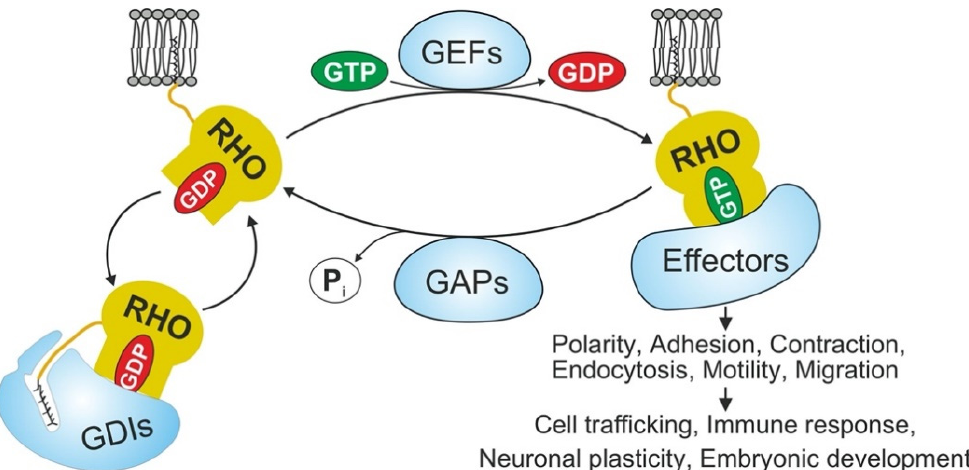
Figure 1. Molecular mechanisms of RHO GTPase regulation and signaling. Most of RHO GTPases (20 canonical members) act as molecular switches, in order to transduce signals from receptors to downstream pathways. This switch mechanism is tightly regulated through three classes of particular proteins: Guanine nucleotide exchange factors (GEFs: 74 DBL and 11 DOCK family members) catalyze the exchange of GDP for GTP, thereby turning on the signal transduction. GTPase-activating proteins (GAPs; 66 ARHGAP family members) bind to GTP-bound RHO GTPases and accelerate their very slow intrinsic GTP hydrolysis, leading to signaling the switch off. Guanine nucleotide dissociation inhibitor (GDIs: three known members) bind to isoprenylated, GDP-bound RHO GTPases and displace them from the membrane. GTP-bound, active RHO GTPases associate with and activate different downstream effectors (more than 70 known members), and thus accomplish various biochemical processes and cellular functions.